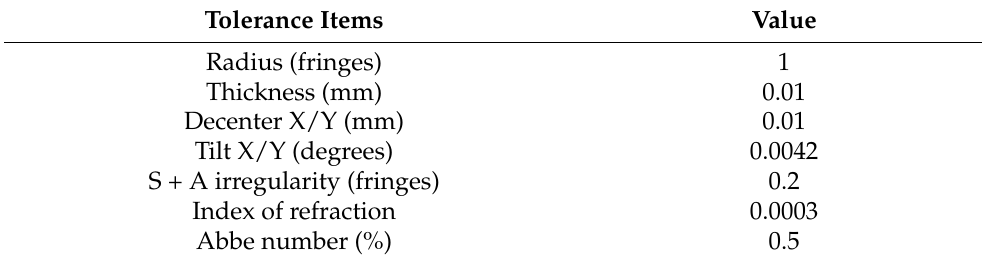
Table 5. Tolerance